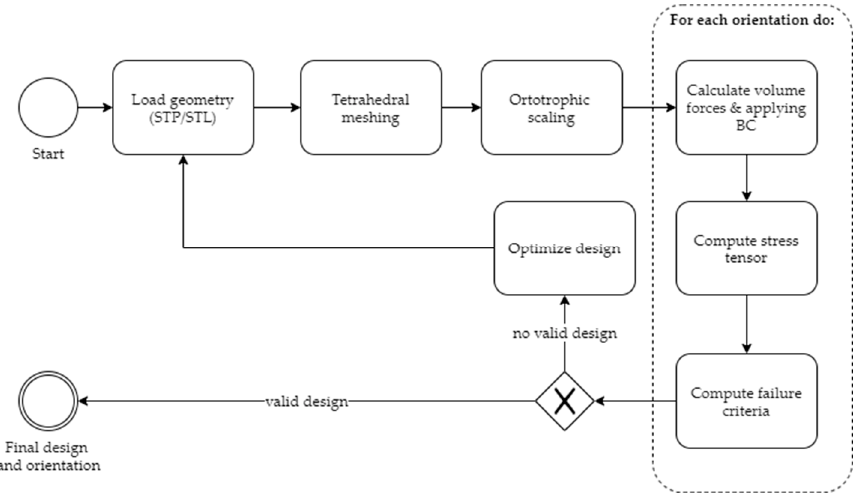
Figure 4. Workflow of the presented automated simulation framework.